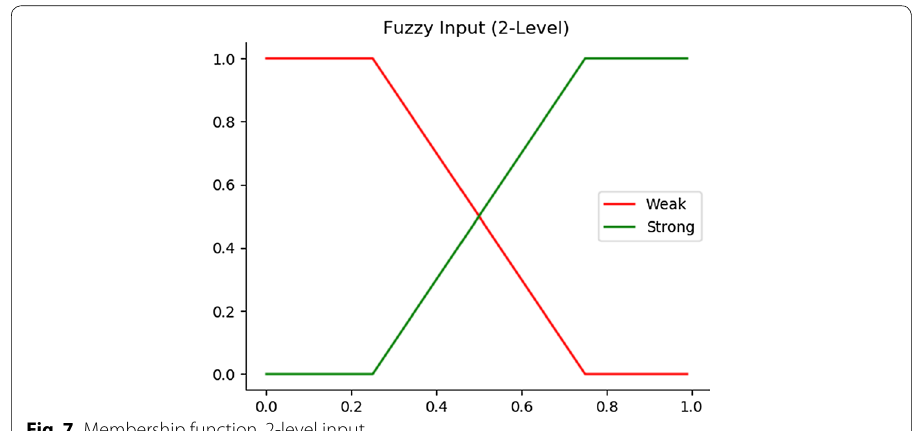
Fig. 7 Membership function, 2-level input